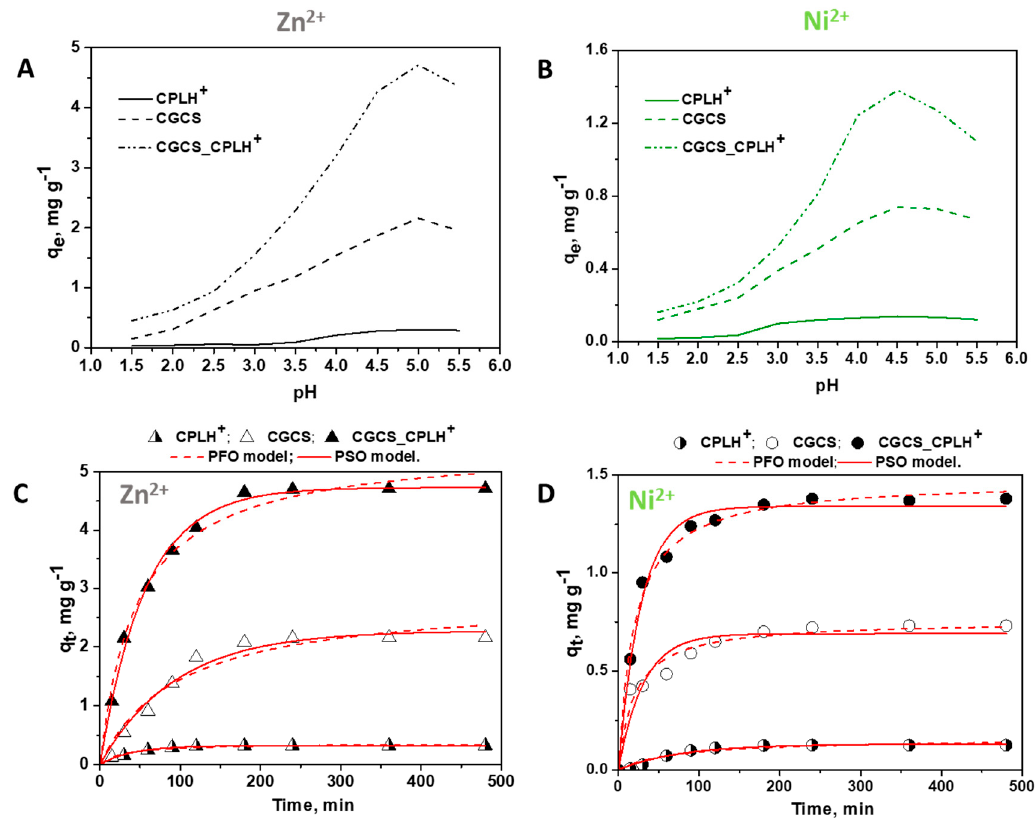
Figure 3. Influence of pH values ( A , B ) and contact time ( C , D ) onto Zn 2 + ( A , C ) and Ni 2 + ( B , D ) ions removal from multicomponent mixtures by CPLH + , CGCS, and CGCS_CPLH + sorbents.